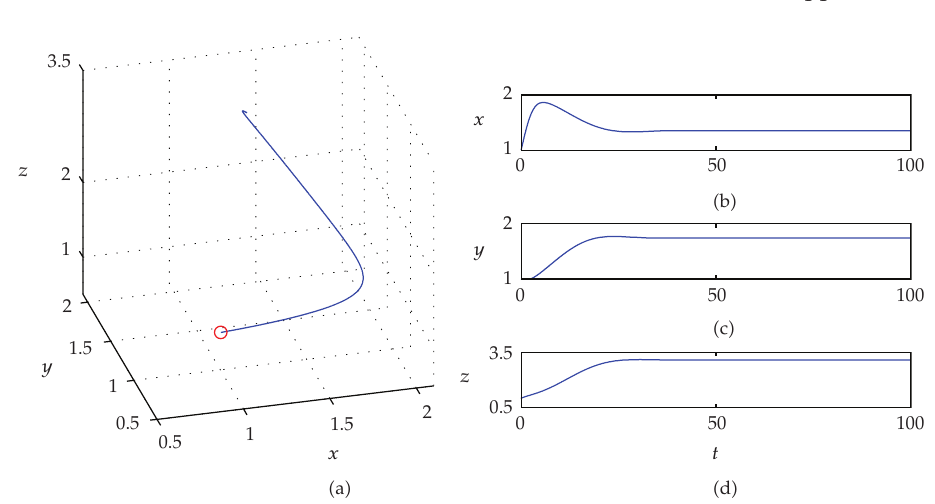
Figure 3: a (cid:7) 1, b (cid:7) 0 . 4, c 1 (cid:7) 0 . 7, c 2 (cid:7) 0 . 6, c 3 (cid:7) 0 . 01, c 4 (cid:7) 1 . 4, d 1 (cid:7) 0 . 3, d 2 (cid:7) 0 . 45, α 1 (cid:7) 1 . 3, α 2 (cid:7) 0 . 6, and β (cid:7) 1 . 0 and an initial condition (cid:3) 1 , 1 , 1 (cid:6) . (cid:3) a (cid:6) The trajectory of the system (cid:3) 1.2 (cid:6) . (cid:3) b (cid:6) – (cid:3) d (cid:6) Time series for x (cid:3) t (cid:6) ,y (cid:3) t (cid:6) , and z (cid:3) t (cid:6)